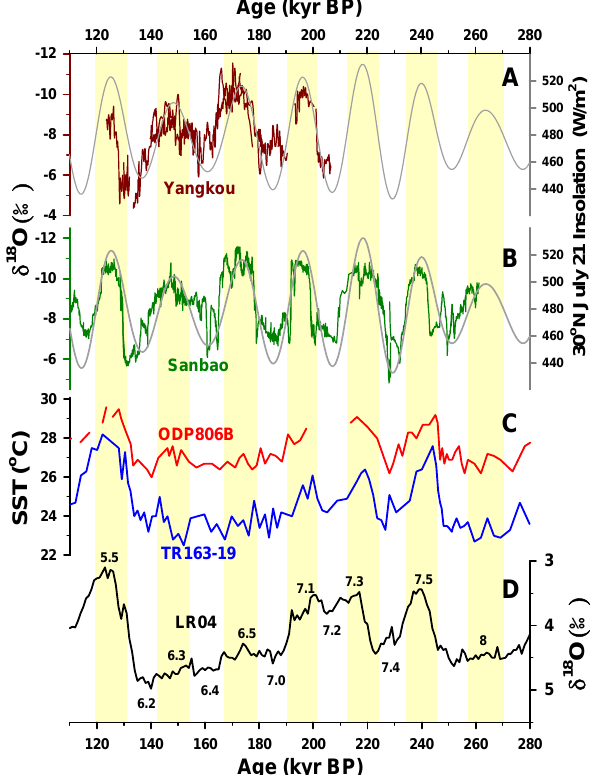
Figure 6. Comparison of Chinese cave δ 18 O records of (A) Yangkou and (B) Sanbao (Wang et al., 2008; Cheng et al., 2009) with (C) reconstructed SST records in the WPWP (core ODP806B) and EEP (core TR163-19) (Lea et al., 2000), and (D) a global stack benthic foraminifer δ 18 O sequence LR04 (Lisiecki and Raymo, 2005). Numbers of MIS 5.5–8 are given by LR04 record. Gray line is NHSI on 21 July at 30 ◦ N. Vertical bars denote high insolation